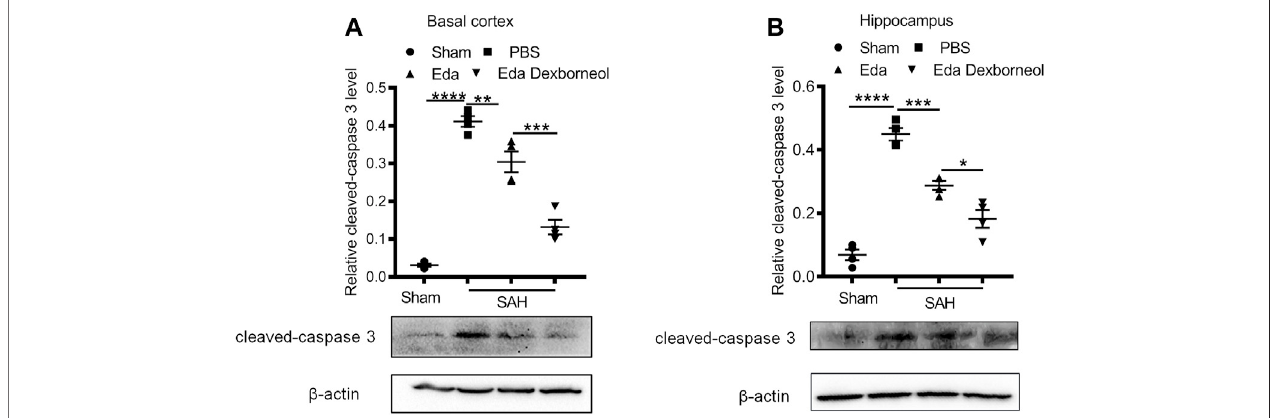
FIGURE 4 | Western blot showing that edaravone dexborneol treatment profoundly decreased the levels of cleaved caspase 3 in the brain after SAH injury. (A,B) Representative Western blot images and semiquantitative data show the expression ofcleaved caspase 3 in the basal cortex (A) and CA1 hippocampus (B) at 3 d after SAH. Data are normalized to sham. n = 4/group. * p < 0.05, ** p < 0.01, *** p < 0.001, **** p < 0.0001. Eda: edaravone; Eda dexborneol: edaravone dexborneol.